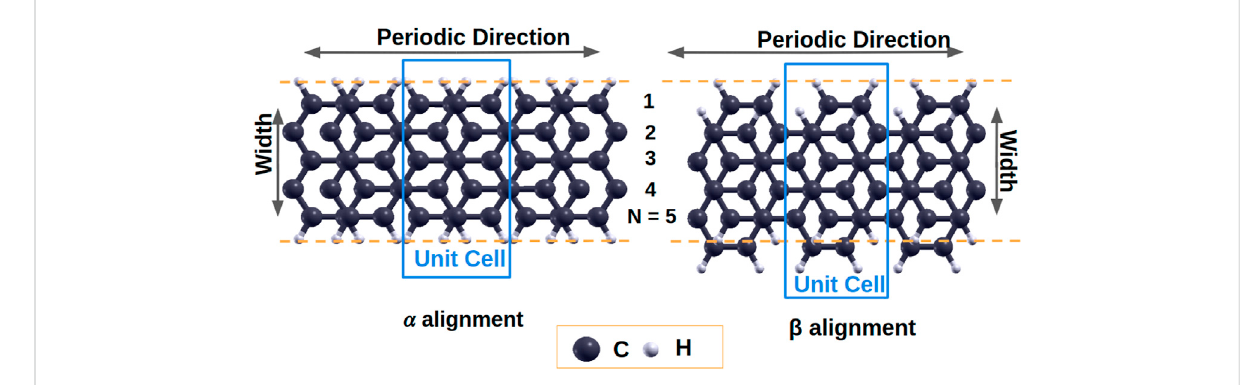
FIGURE 8 Bilayer armchair graphene nanoribbons α and β